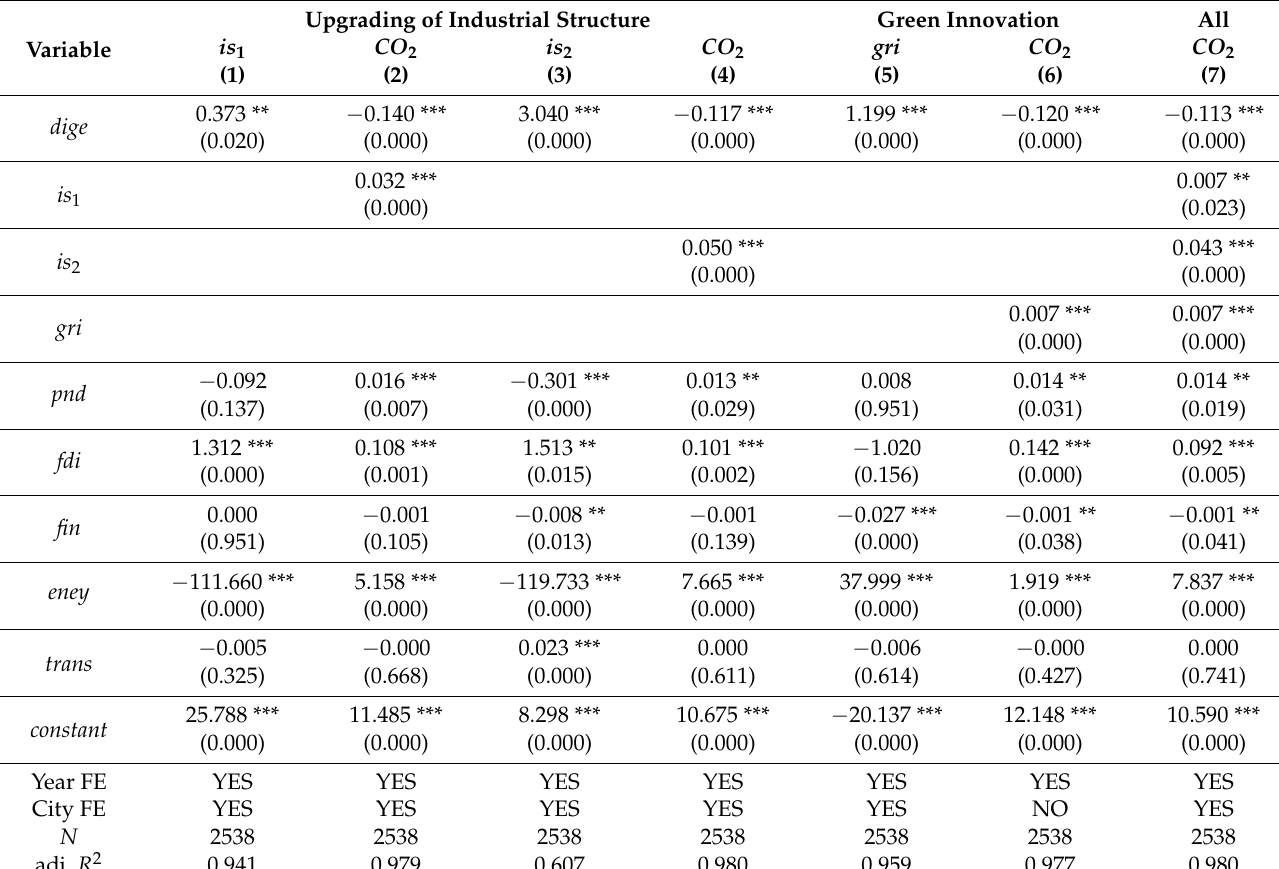
Table 8. Mechanism test